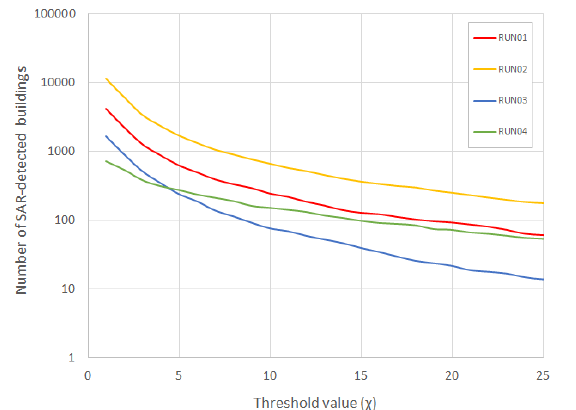
Figure 7: Number of changed buildings based on different thresh- old values χ